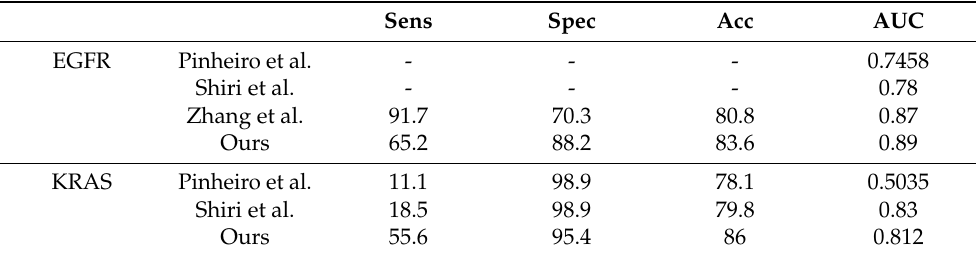
Table 3. Comparison between our proposed models and those of previous studies using the same TCIA data. Sens Spec Acc AUC EGFR Pinheiro et al. - - - 0.7458 Shiri et